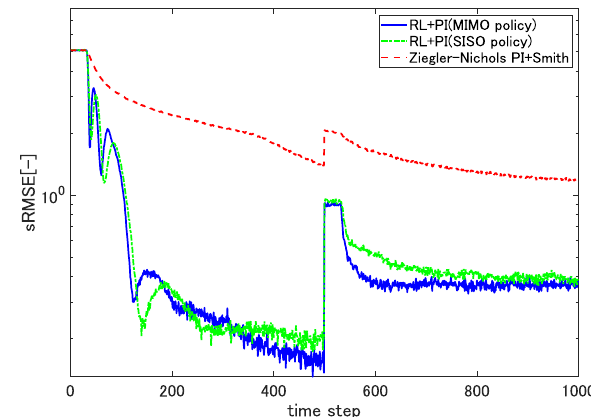
Figure 15. Effect of disturbance on the spatial RMSE